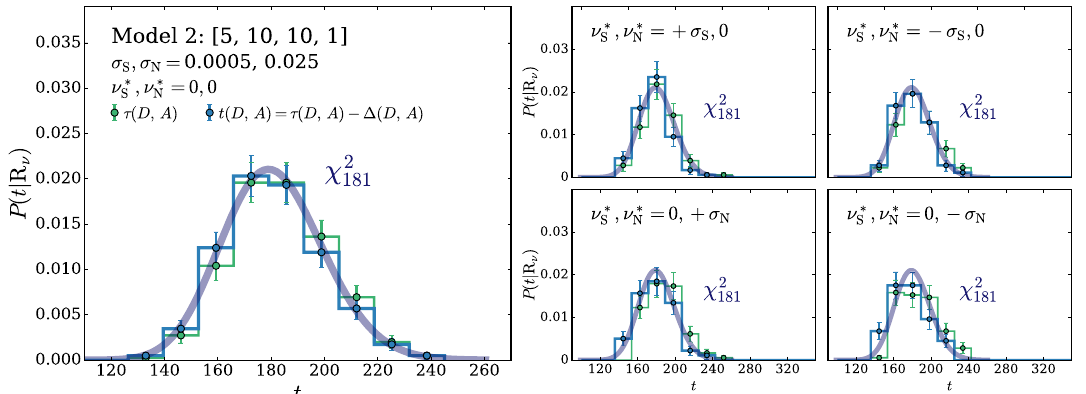
Fig. 15 The empirical distribution of τ (in green) and of t (in blue) computed by 100 toy experiments performed in the R ν hypothesis at different points in the nuisance parameters space for the muon-like regime. The χ 2